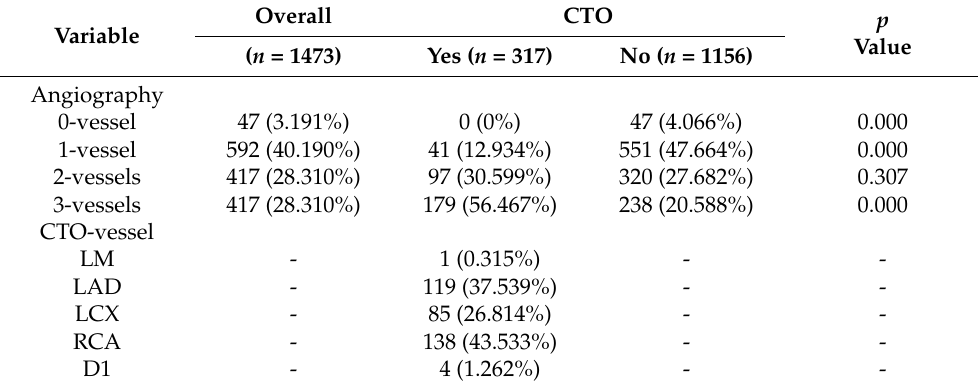
Table 3. Baseline clinical angiography characteristics of the study